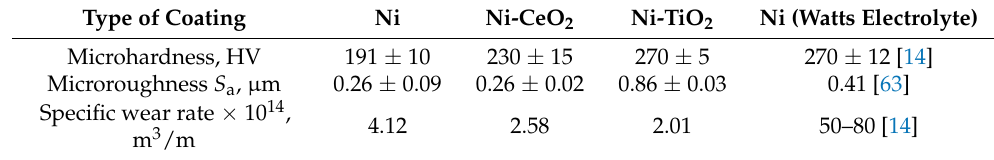
Table 5. Microhardness, microroughness, and wear rate of nickel and composite nickel-based coatings. Type of Coating Ni Ni-CeO